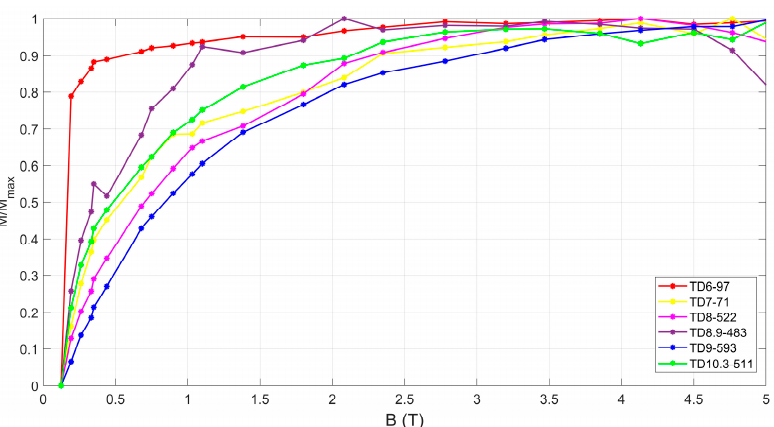
Figure 3. Progressive acquisition of isothermal remanent magnetization (IRM) up to 5 T of repre- sentative samples of each unit.